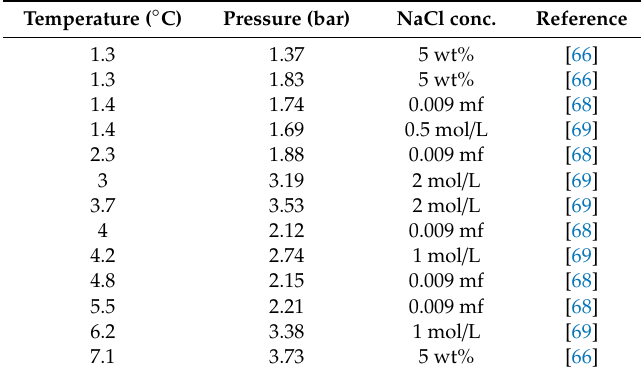
Table 13. Carbon dioxide hydrate equilibrium data in presence of NaCl, currently available in the